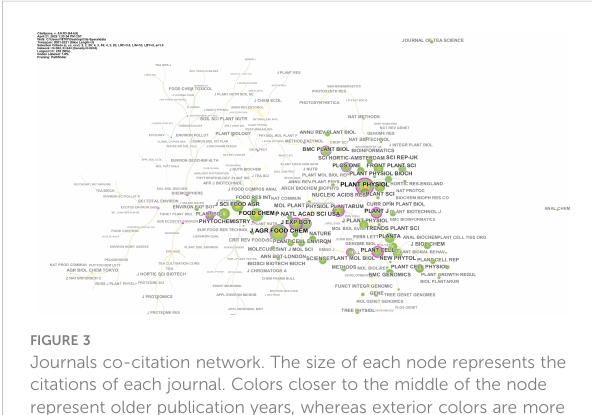
FIGURE 3 Journals co-citation network. The size of each node represents the citations of each journal. Colors closer to the middle of the node represent older publication years, whereas exterior colors are more recent publication years. The purple circle means the node ’ s centrality ≥ 0.1, and the size of the circle is proportional to the centrality